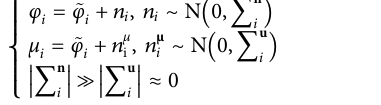
Figure 3D. The pro fi le of network denoising result is shown by the red curve, while the pro fi le of noise-free phase is represented by the blue curve. Thetwo curves have a meandeviation error of 0.2838rad, less than 0.1 wavelength. It demonstrates that the network denoising results accurately portray the samples ’ real phase